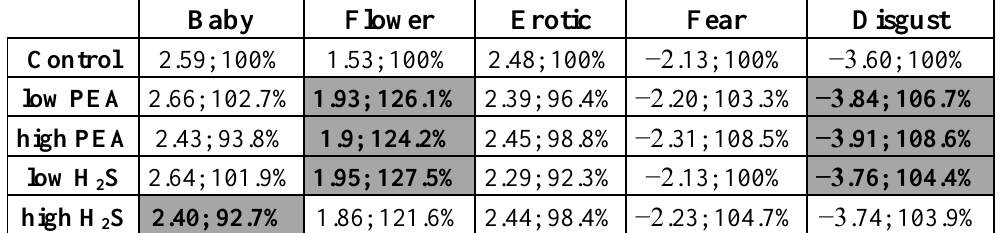
Table1. Mean valence intensity ratings related to all picture categories and for every single olfactory condition. In addition, relative changes in rating performance are displayed in